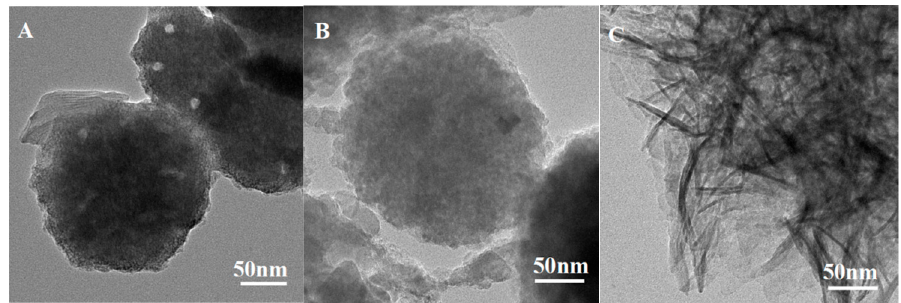
Figure 4. TEM images of ( A ) PS, ( B ) CPS, and ( C ) K-Ac.